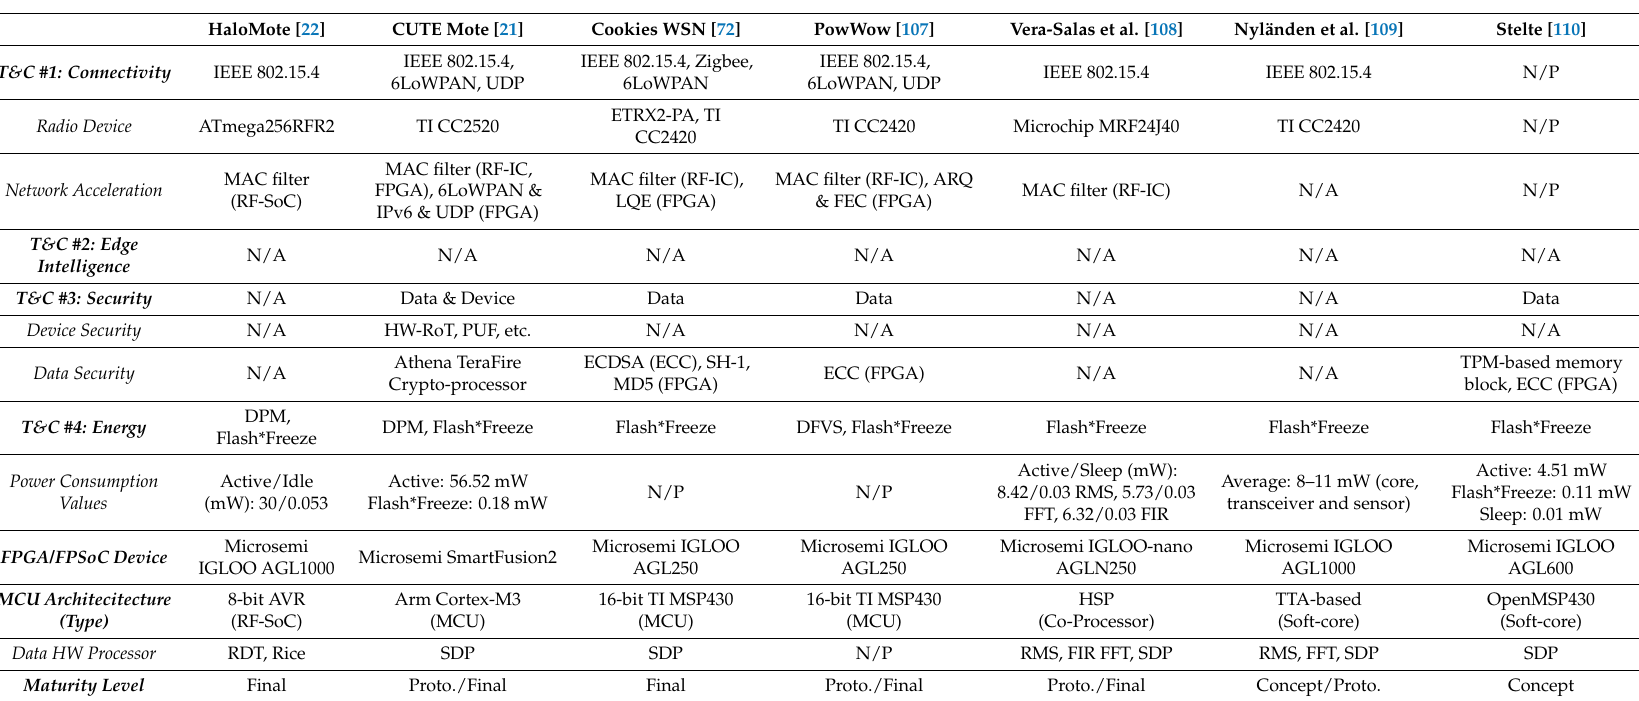
Table 3. Summary of available IoT motes and supported IoT/REC-T&Cs, detailing the most important features and characteristics: radio device, available network accelerators, security-related hardware/software features, SoC, MCU architecture, application-specific accelerators, and maturity level. N/A: information not available; N/P: information is not